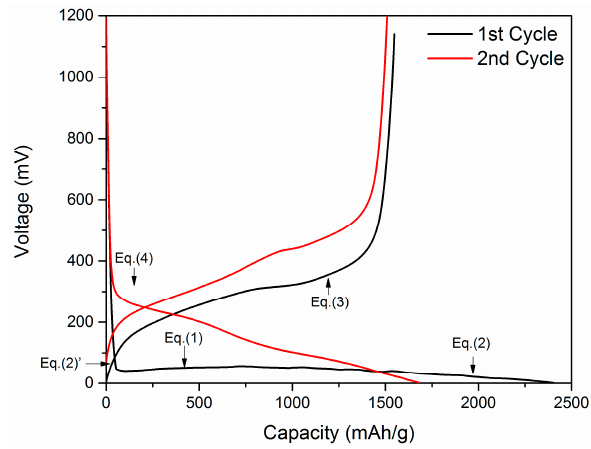
Figure 2. A typical charging/discharging curve for Si anode (~100 nm Si electrode, Polyvinylidene fluoride (PVDF) and Carbon Black; weight ratio 7:2:1, no further modification).